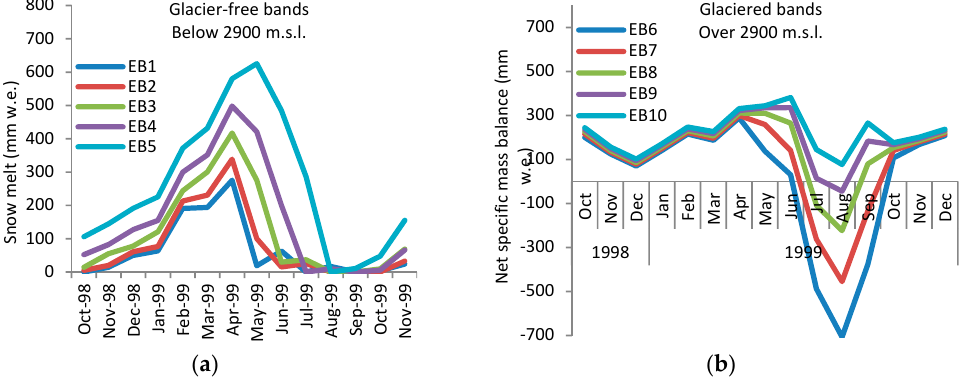
Figure 6. Seasonal melting from the elevation bands from October 1998 to October 1999: ( a ) glacier free elevation bands with seasonal snow cover; ( b ) high elevation bands with permanent snow cover or glacier.